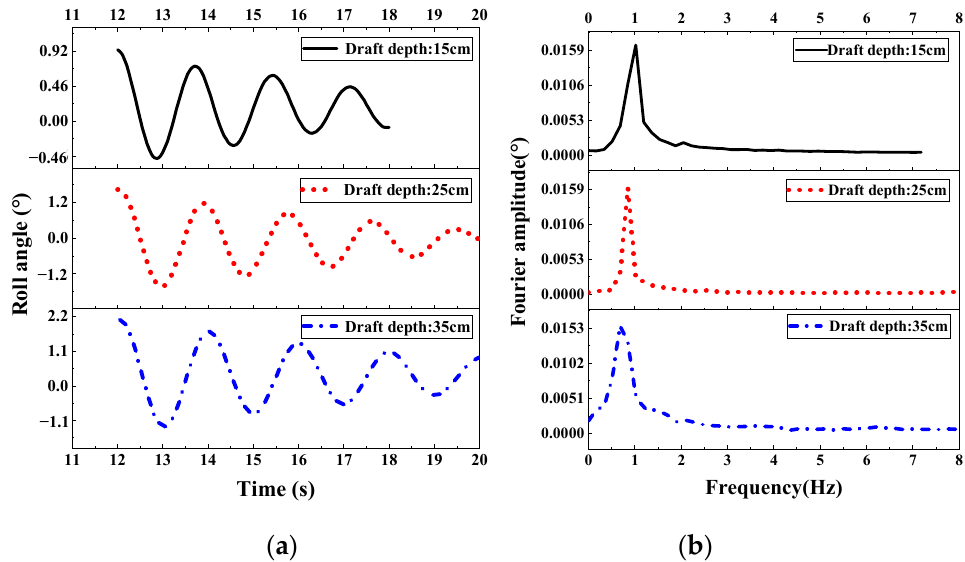
Figure 10. Natural period of roll for different drafts. ( a ) Roll attenuation curve. ( b ) Spectrum diagram